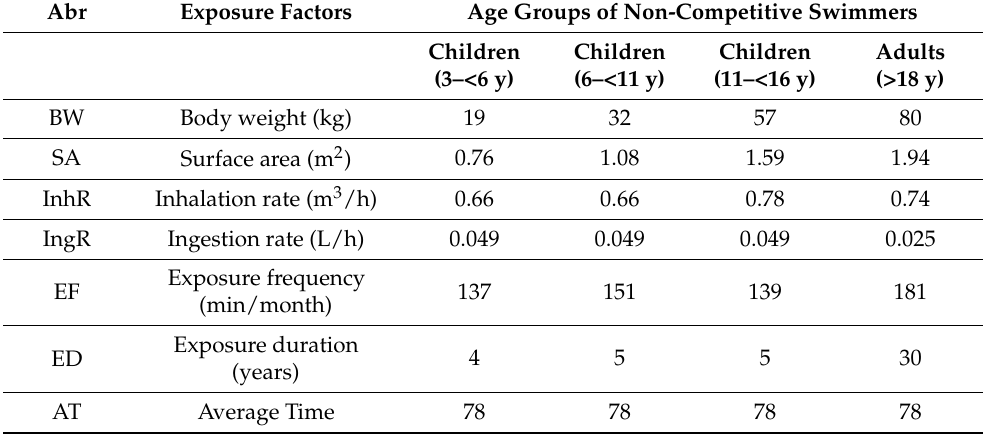
Table 3. Exposure factors for non-competitive swimmers